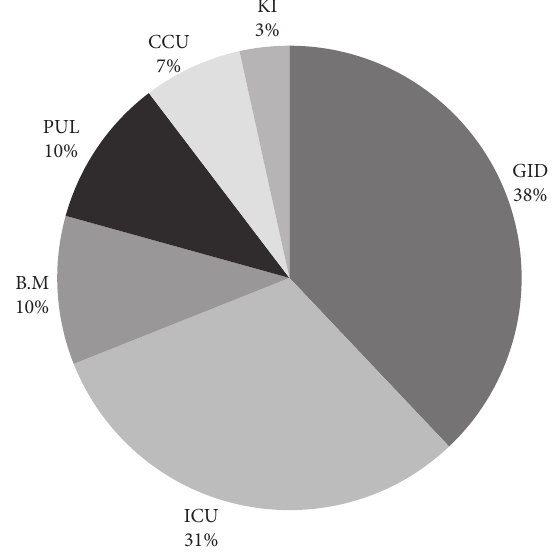
Figure 1: Prevalence of Clostridium difficile infection between inpatients of critical hospital wards (GID: gastroenterology, ICU: intensive care unit, BM.: bone marrow transplantation, PUL: pulmonary disease, CCU: cardiac surgery, and KI: renal